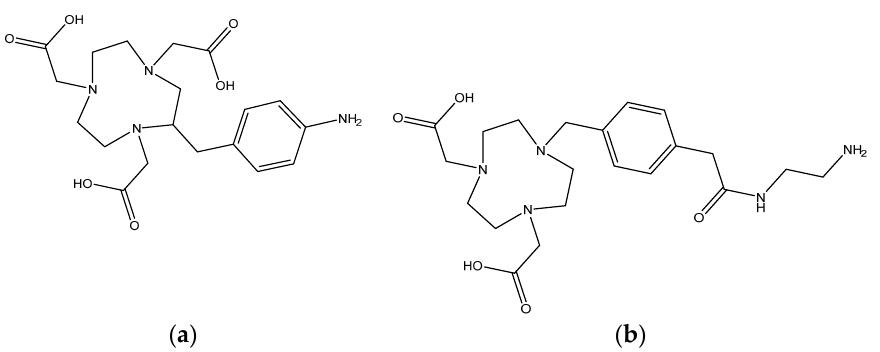
Figure 2. Molecular structures of chelators investigated in this study: ( a ) p-NH 2 -Bn-NOTA (termed NOTA*), and ( b ) NH 2 -MPAA-NODA (termed NODA*).